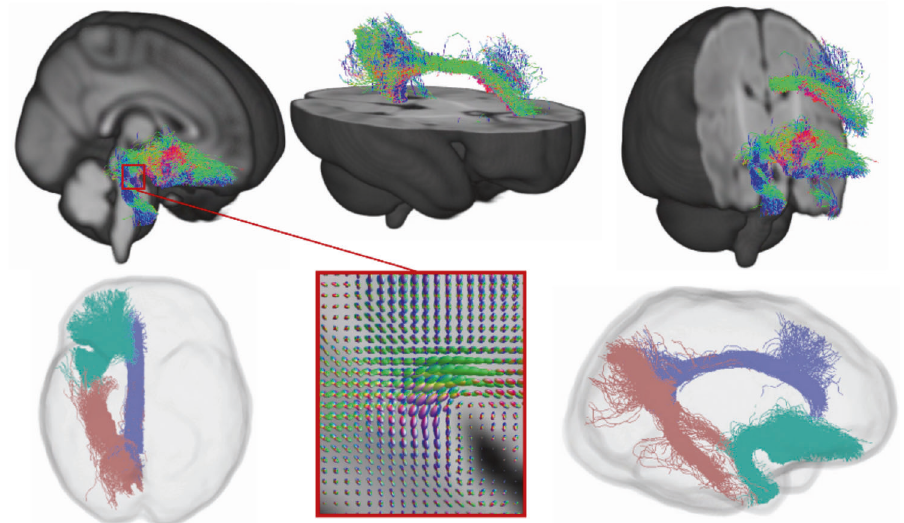
Fig. 1 Visual representation of the tracts in template space. The top row shows the location of the tracts, coloured by streamline orientation (blue: superior-inferior, red: left-right, green: anterior-posterior). On the bottom row, the middle image shows an example of fi bre orientation distributions in a region of crossing fi bres, while the left and right images represent “ glass-brain ” illustrations of the tracts of interest (pink: ventral cingulum, purple: dorsal cingulum, turquoise: uncinate